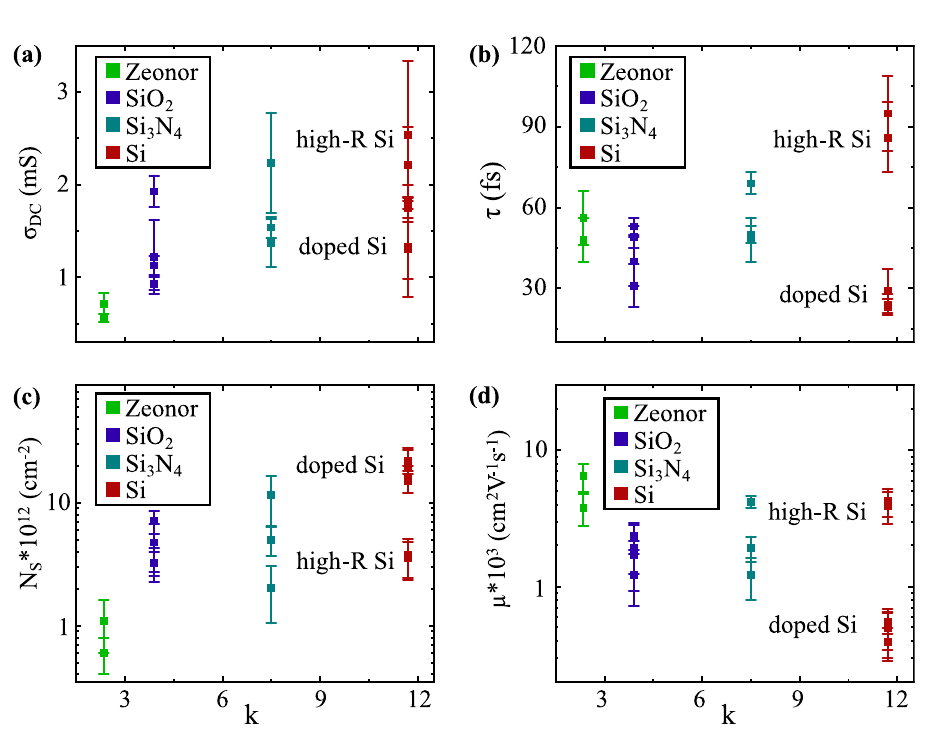
Figure 4. Experimentally measured transport parameters plotted as a function of the substrate dielectric constant κ: ( a ) DC conductivity σ DC, ( b ) scattering time τ , ( c ) carrier density N S , and ( d ) mobility μ